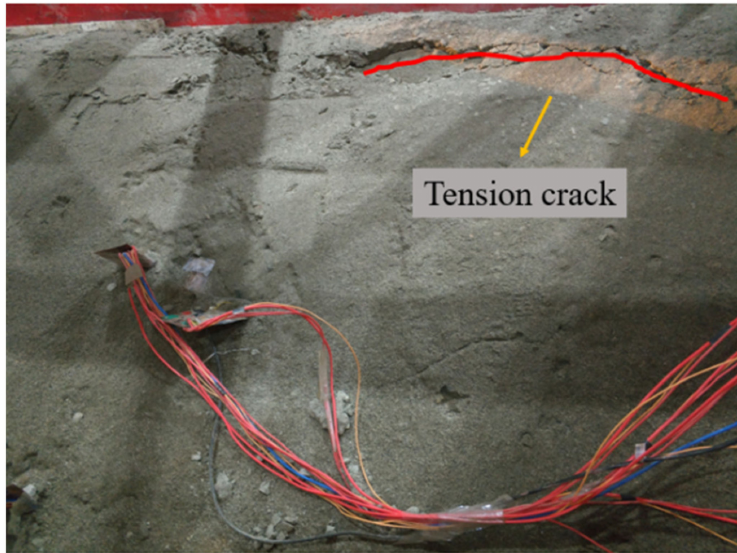
Figure 8. Slope top after 0.6 g sine wave first loading.